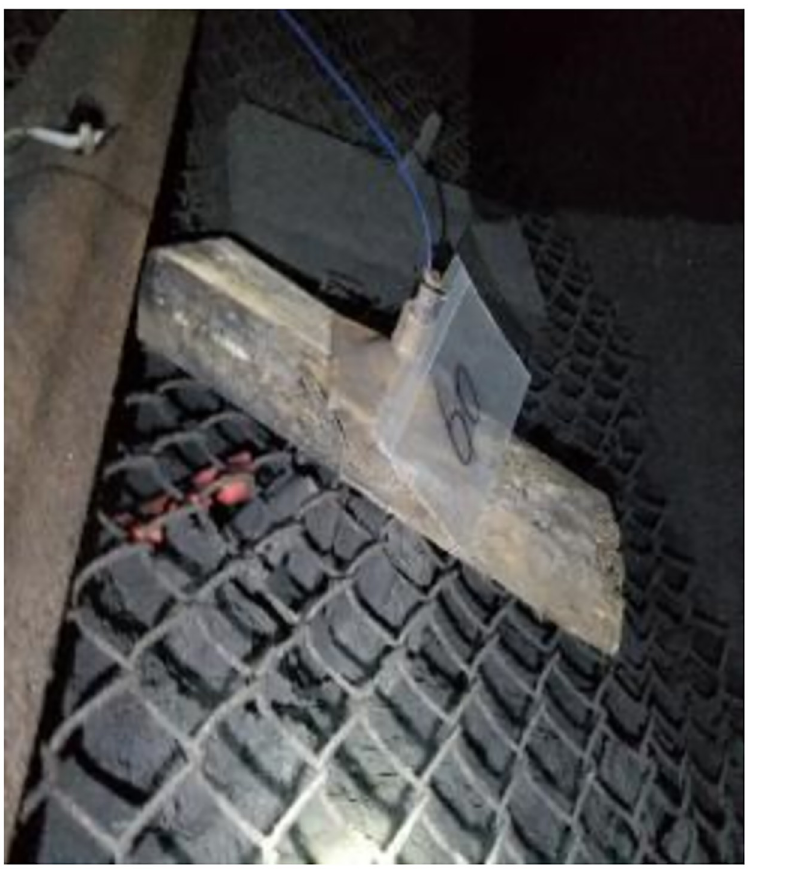
Fig 20. One of the bolt installation